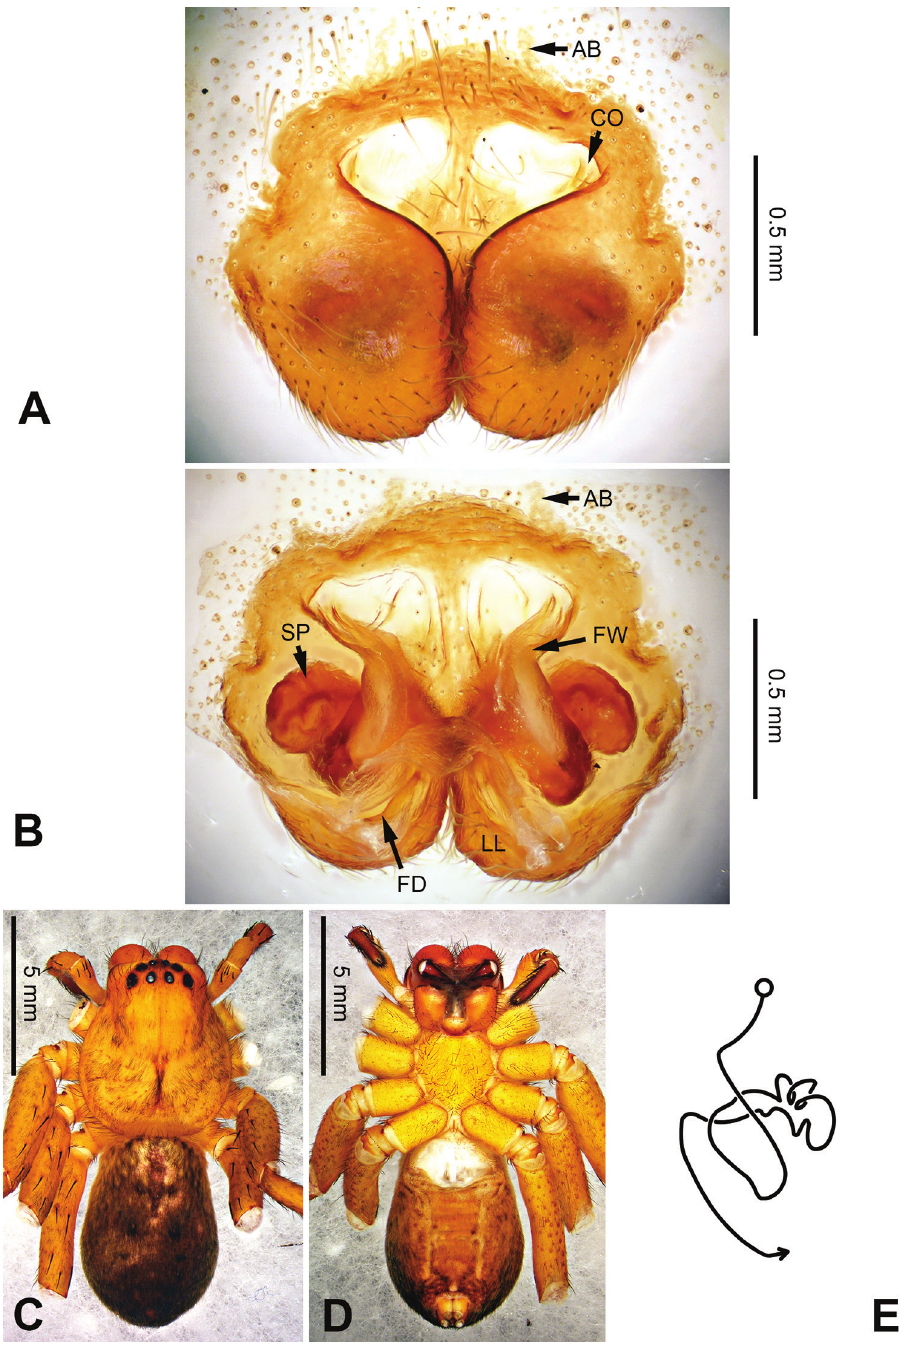
Figure 36. Pseudopoda zixiensis Zhao & Li, sp. n., paratype female. A Epigyne, ventral view B Vulva, dorsal view C Habitus, dorsal view D Habitus, ventral view E Schematic course of internal duct system, dorsal